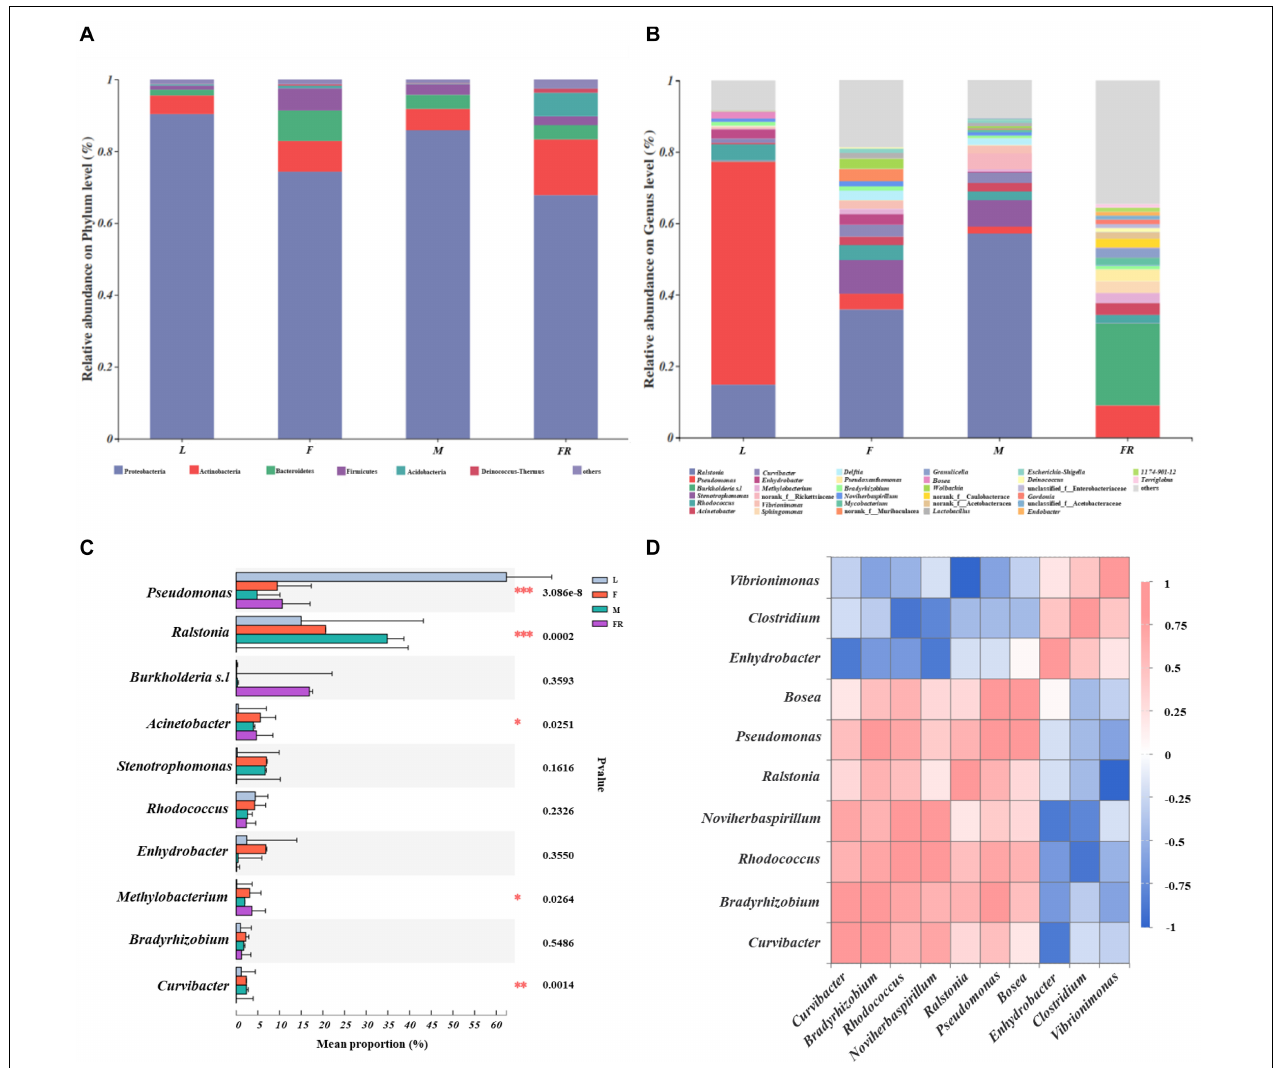
FIGURE 3 | Taxonomic composition of bacterial communities associated with Sirex noctilio gut and frass. Relative abundance of each bacterial (A) phylum, and (B) genus. Each bar is indicated by a different color at phylum and genus level. OTUs that were < 1% of average relative abundance in groups are summarized as “others”. (C) Significant differences of microbial composition in larvae, female adults, male adults, and frass in the relative abundance of top ten (one-way ANOVA followed by Scheffe test; ∗ 0.01 < P ≤ 0.05, ∗∗ 0.001 < P ≤ 0.01, ∗∗∗ P ≤ 0.001). (D) Spearman correlations of samples with the OTU abundance of genus in S. noctilio larval gut in the relative abundance of top ten. Blue boxes represent co-exclusion/negative correlations; red boxes represent co-occurrence/positive correlations between microbes (L, larva; F, female; M, male; and FR,